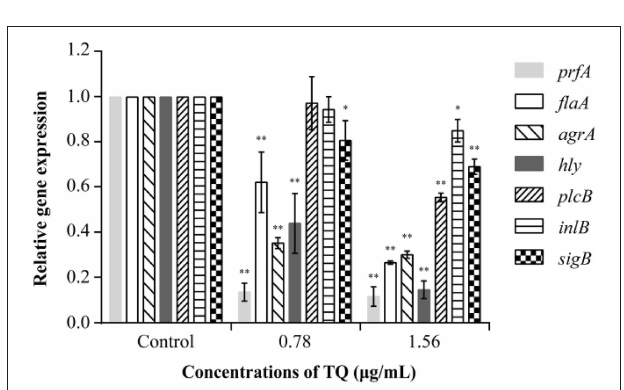
FIGURE 7 | Effect of thymoquinone (TQ) on the transcription of Listeria monocytogenes ATCC 19115 virulence genes. Bars indicate the standard deviation ( n = 3). * P < 0.05; ** P <